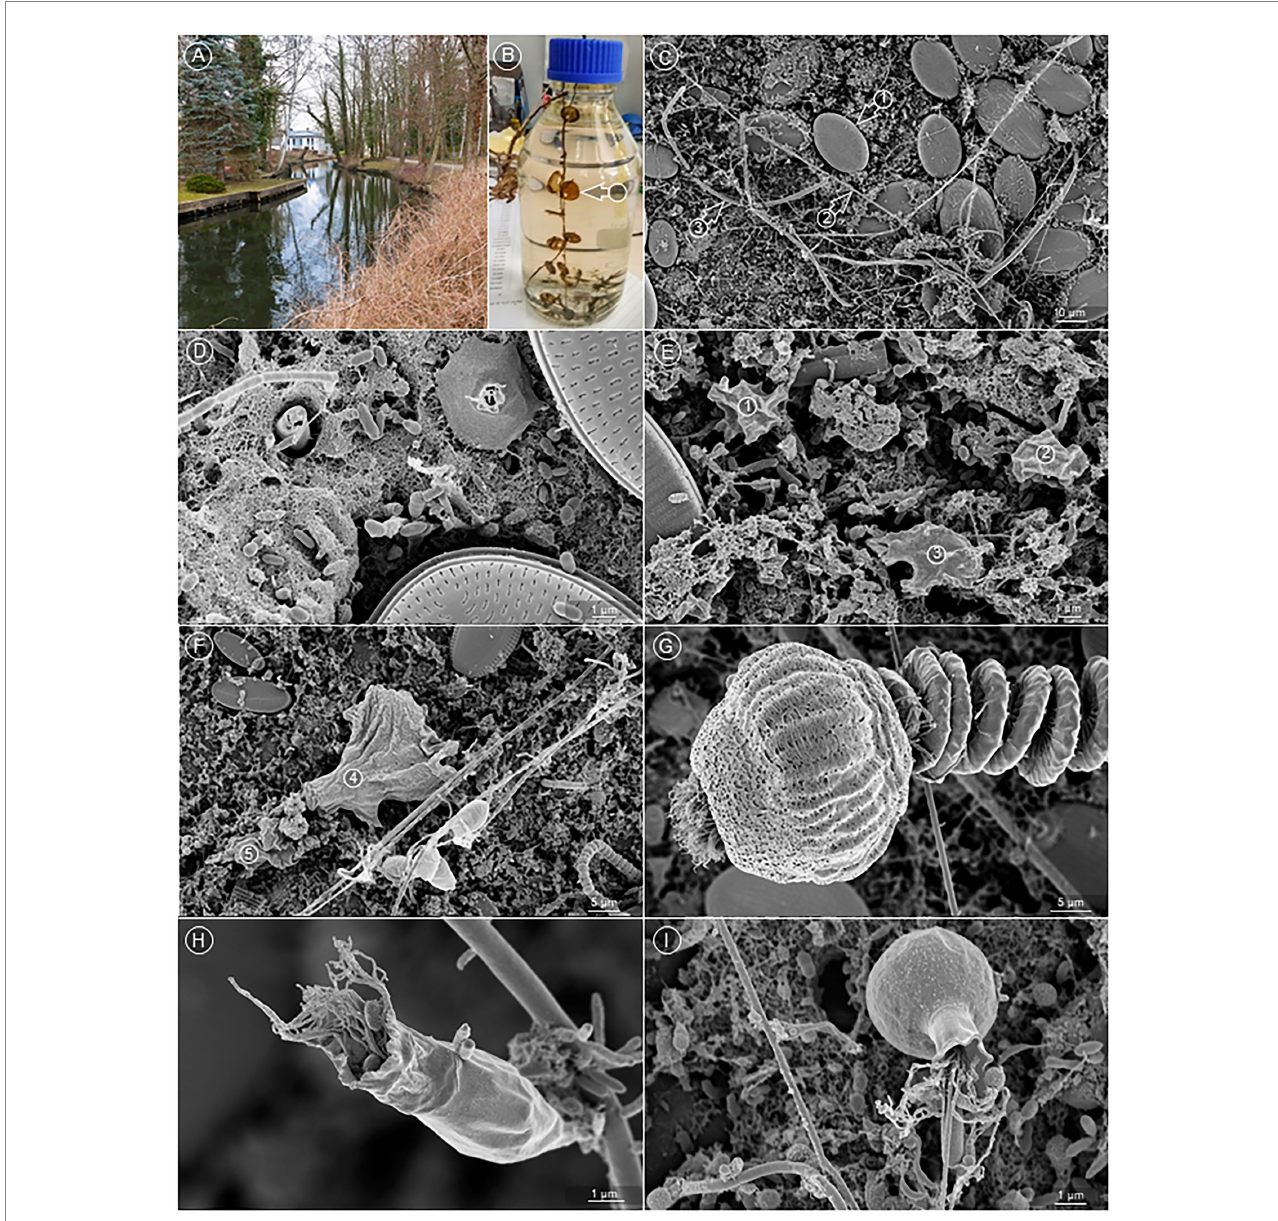
FIGURE 3 An ex vivo biofilm from natural water. (A) Sampling location at the Bretter ditch in Brandenburg, Germany. (B) Sampled Thermanox ™ coverslips (arrow) colonized with aquatic biofilm, transferred into a glass flask for the transport to the laboratory. (C) Overview of the biofilm. Readily visible are diatoms (arrow 1), bacteria, wrapped in a long, filamentous sheath (arrow 2), and hyphae of fungi (arrow 3). (D) The bottom layer of the biofilm is constituted by numerous bacteria, which are mostly embedded in a fibrous matrix. (E,F) Various amoebae were found on top of the bacterial bottom layer (circles 1–5). (G) Vorticella spp. were frequent constituents of the aquatic biofilm, (H,I) as were a great variety of other bacteria eating